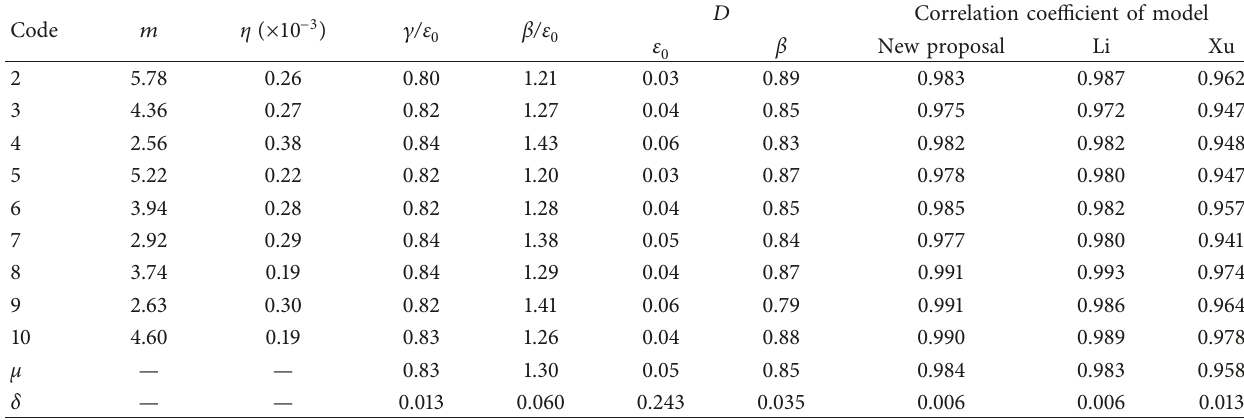
Table 4: Parameters of damage constitutive